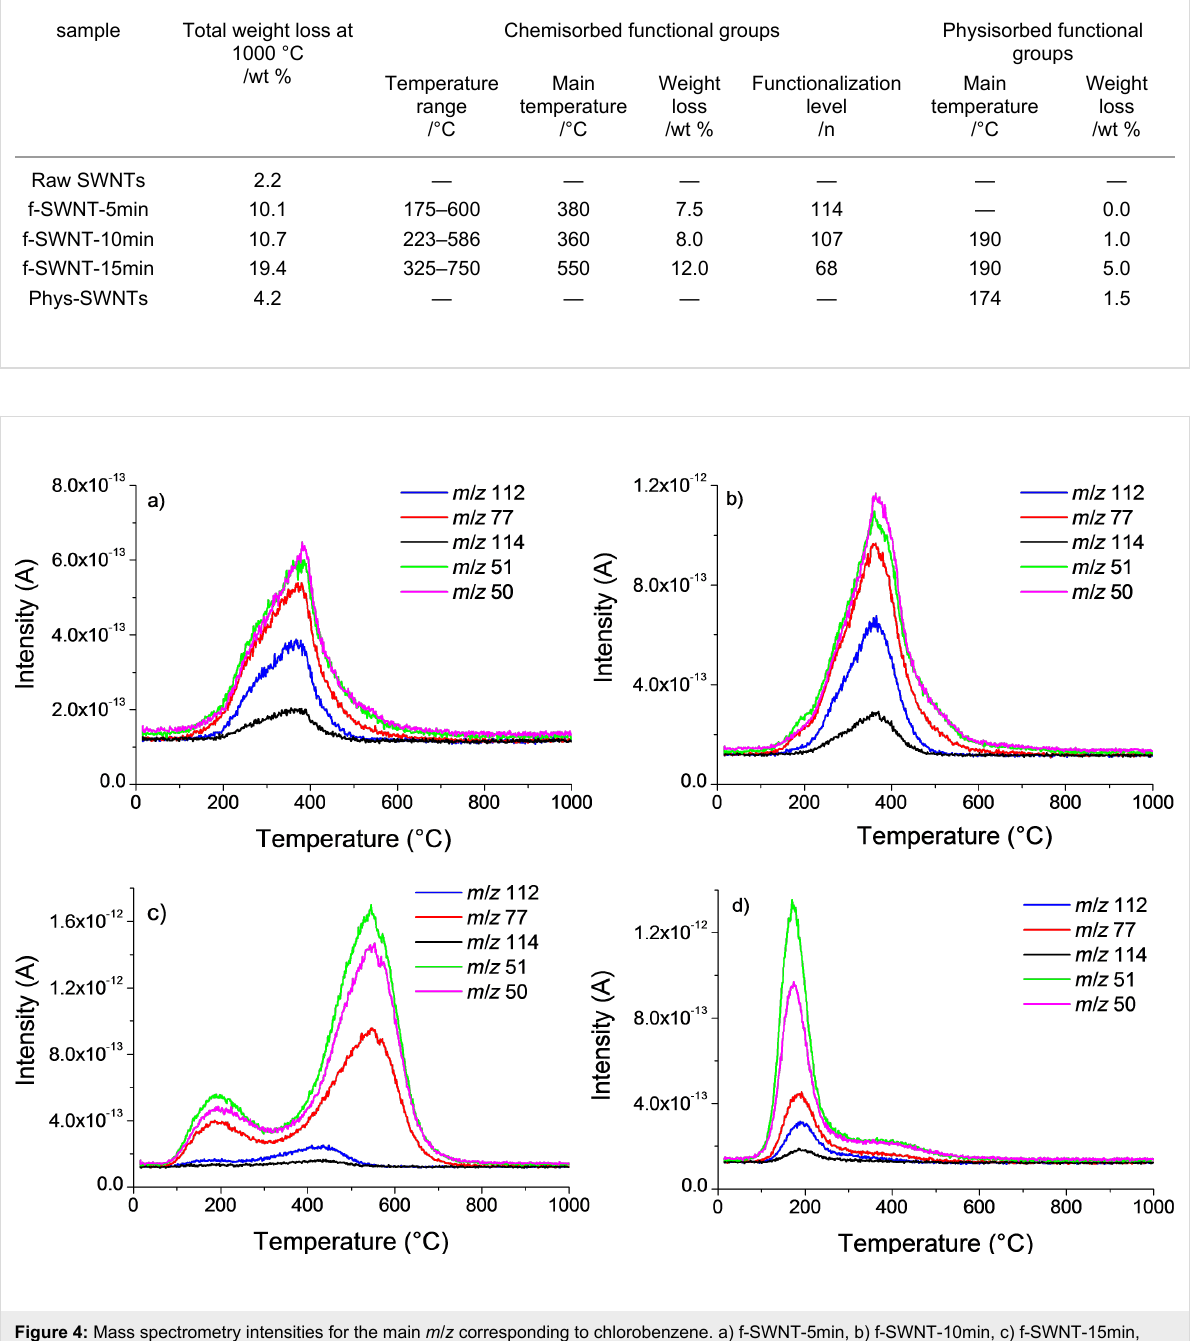
For the four samples, the m / z of the expected fragments for chlorobenzene could be detected, and as the intensity profile of each mass is comparable they can be considered without ambi- guity as the signature of chlorophenyl groups grafted at the sample surface. Clearly, their departure occurs according to